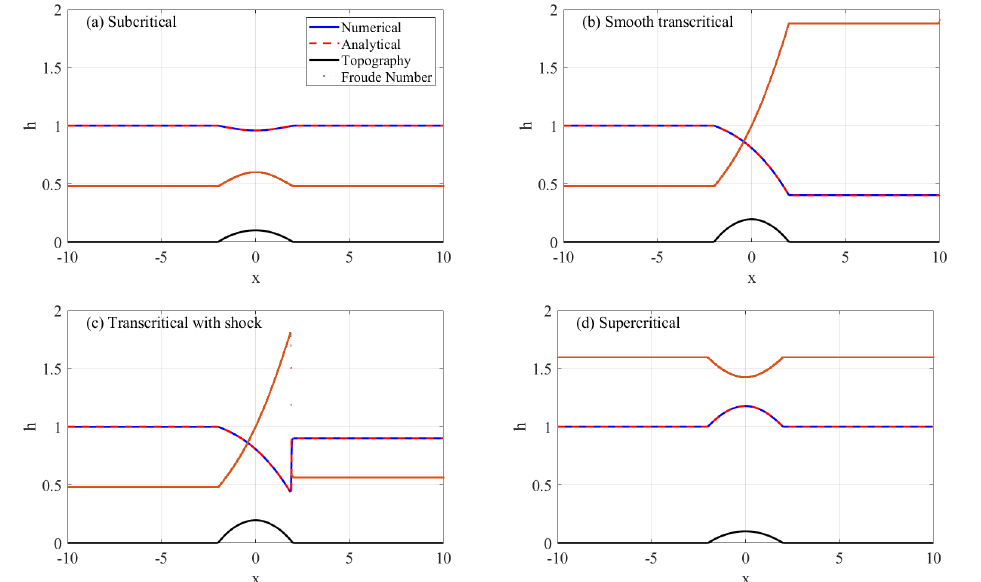
Figure 5. Various flow over a bump through a constant channel width for − 10 ≤ x ≤ 10, for cases ( a ) subcritical, ( b ) smooth transcritical, ( c ) transcritical with shock, ( d )